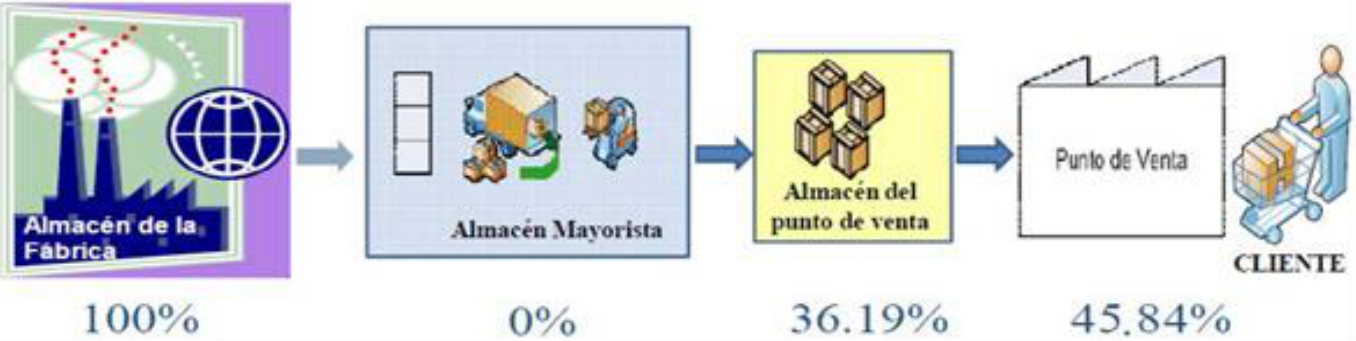
Figura 2: Porcentaje de disponibilidades de aceite en los actores de la Cadena de Suministro . Fuente: